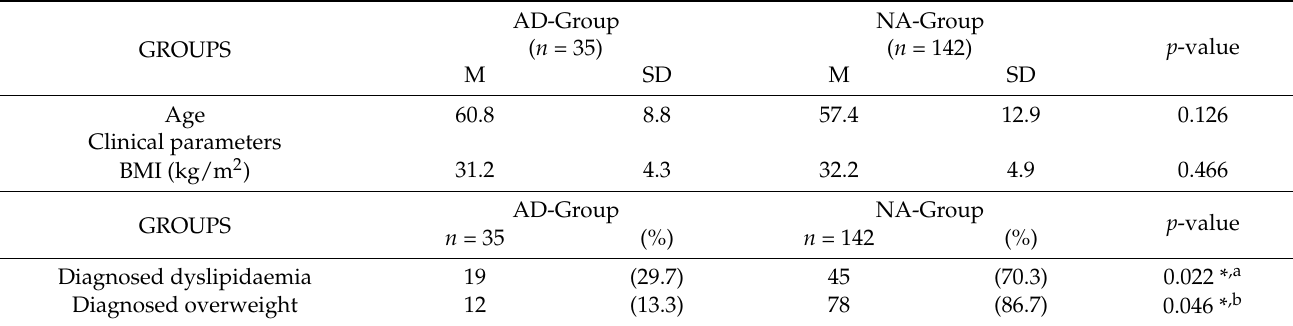
Table 4. Homogeneity at baseline (M1) between groups by